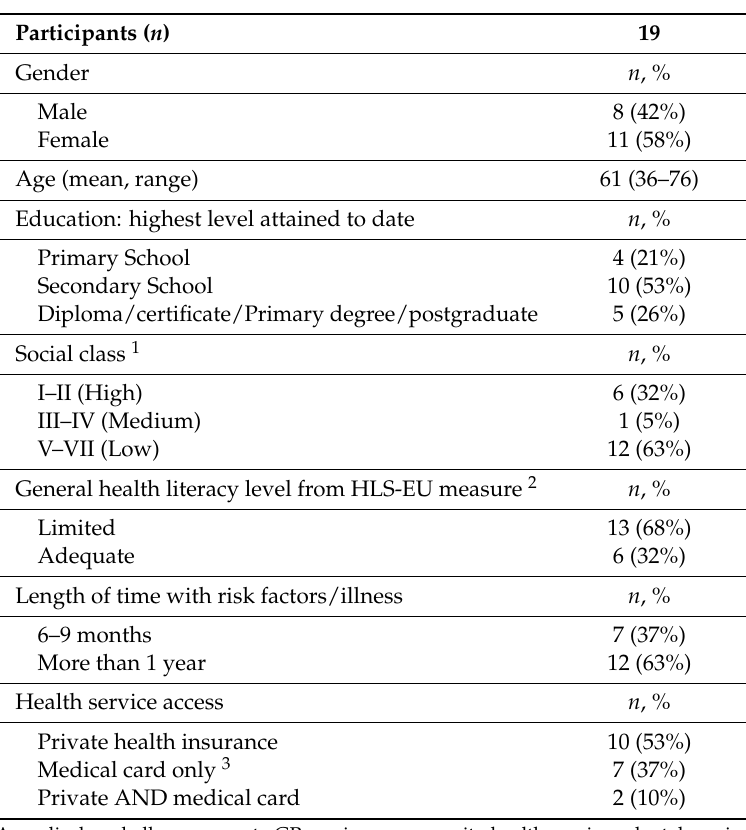
Table 2. Profile of study